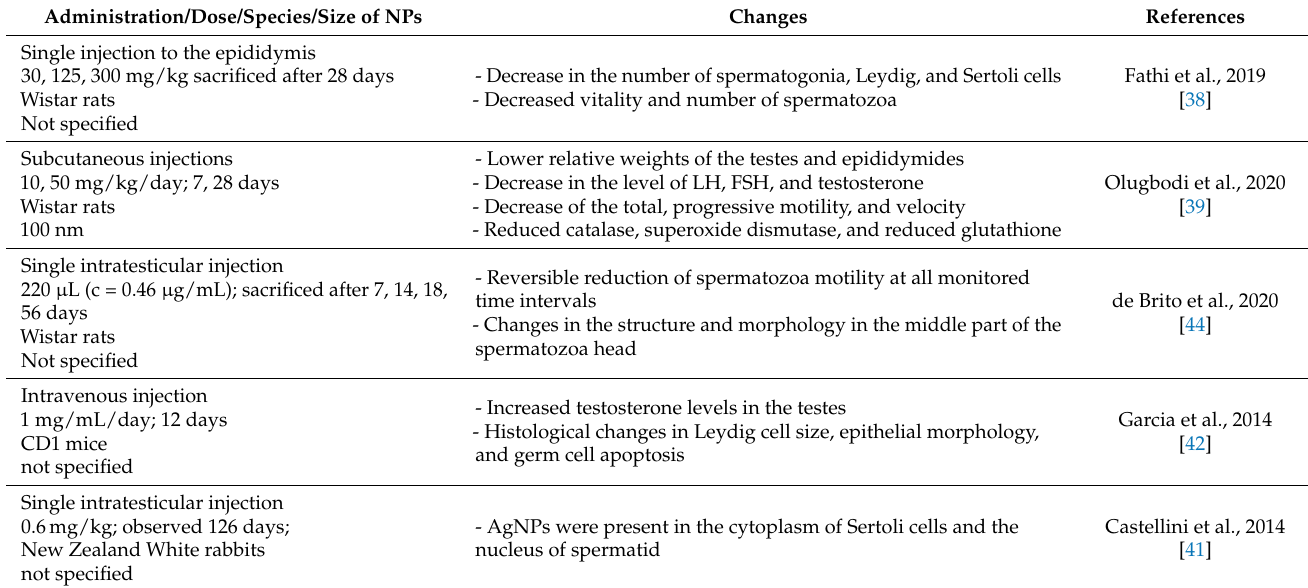
Table 1. Alterations in the male reproductive system caused by